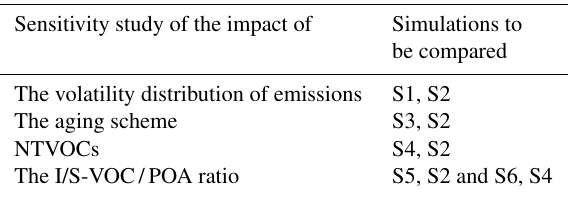
Table 5. Links between the compared simulations and the sensitiv- ity parameters studied. Sensitivity study of the impact